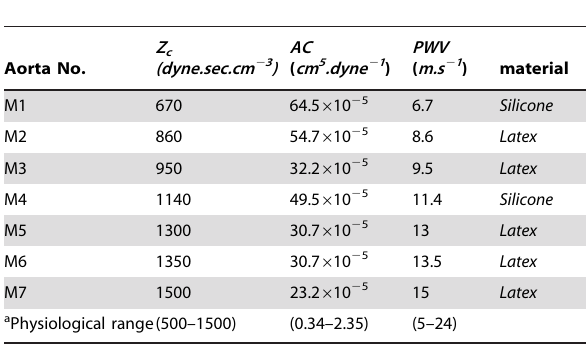
artificial aortas.